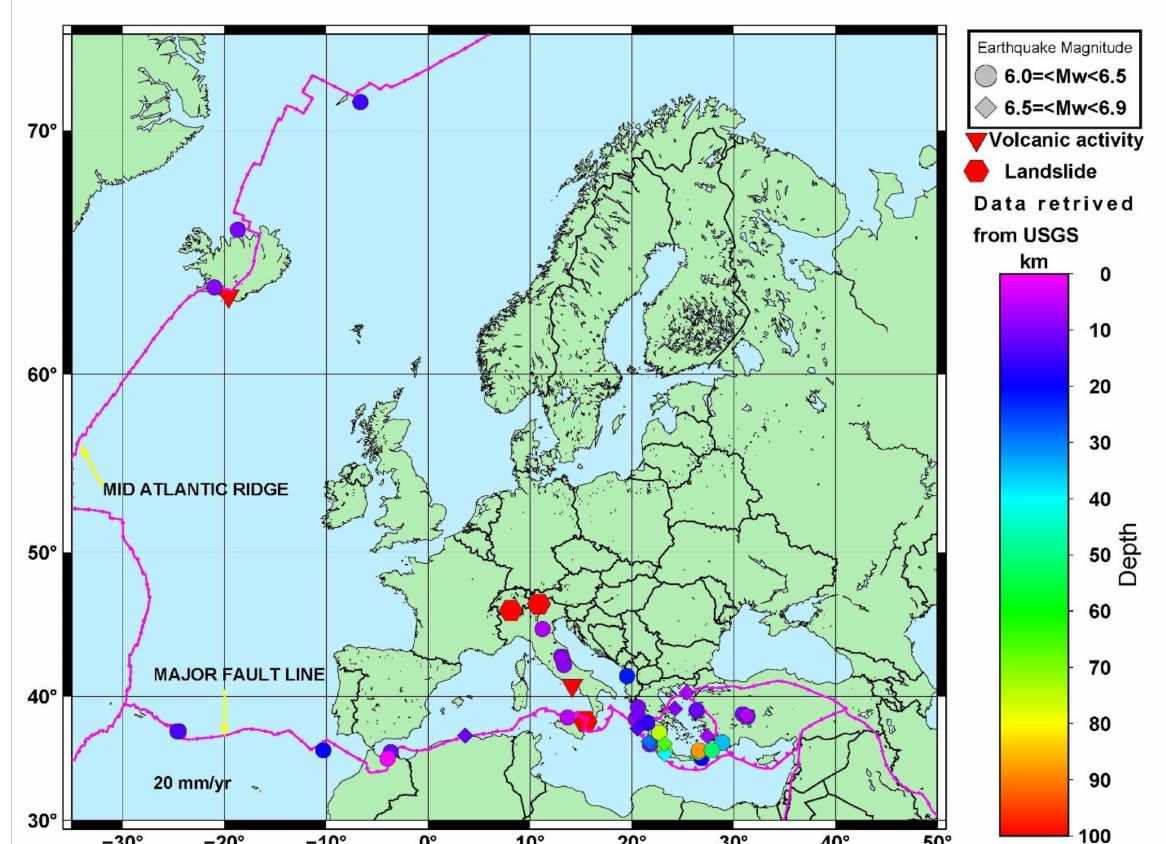
Figure 3. Geophysical events which occurred between 2000 and